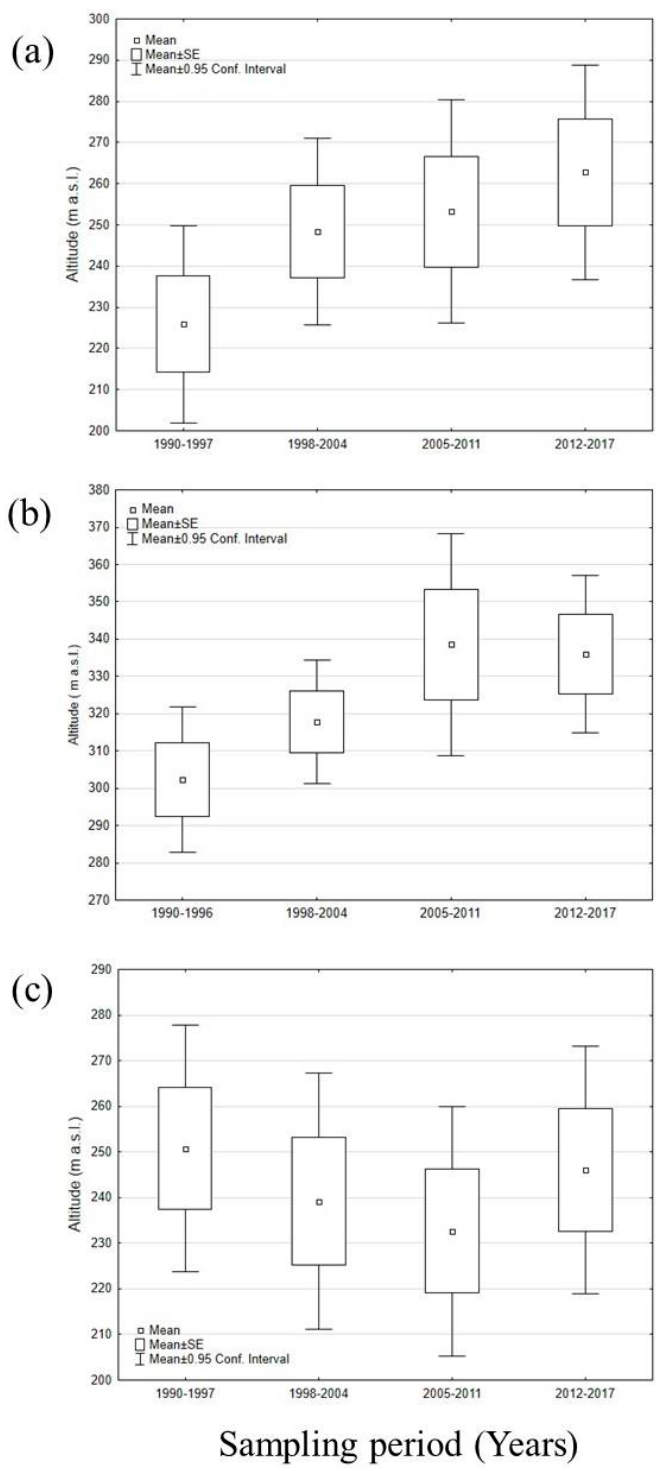
Figure 6. Trend over time of the mean altitude values for: ( a ) Squalius lucumonis , ( b ) Telestes muticellus and ( c ) Padogobius nigricans considering only the occurring sites in the census periods 1990–1997, 1998–2004, 2005–2011, 2012–2017.